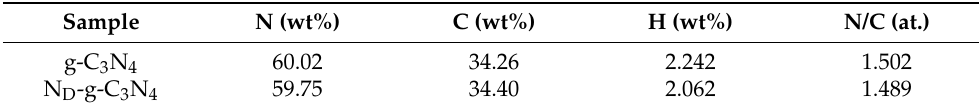
Figure 2. ( A ) XRD patterns, ( B ) FTIR spectra and XPS spectra of g-C 3 N 4 and N D -g-C 3 N 4 : ( C ) Survey spectra, ( D ) O 1s, ( E ) C 1s and ( F ) N 1s. Table 1. Element composition of g-C 3 N 4 and N D -g-C 3 N 4